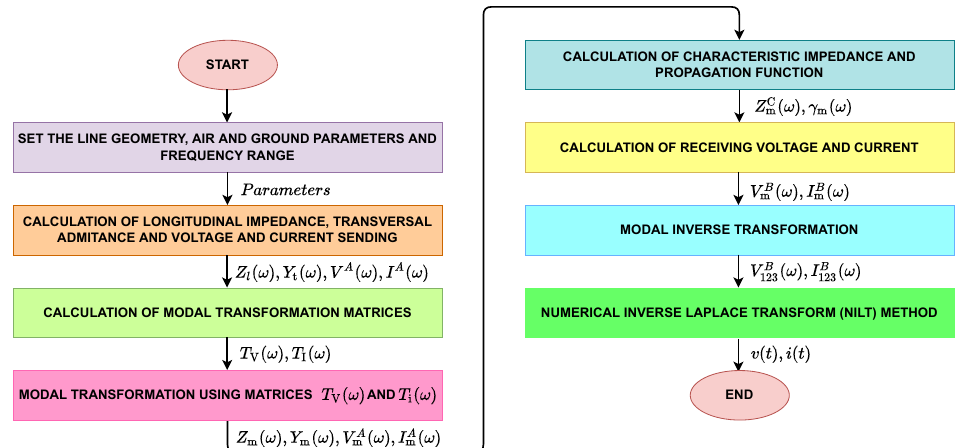
Figure 5. Flow-chart with the the voltages and currents on a three-phase OHTL using the modal decomposition